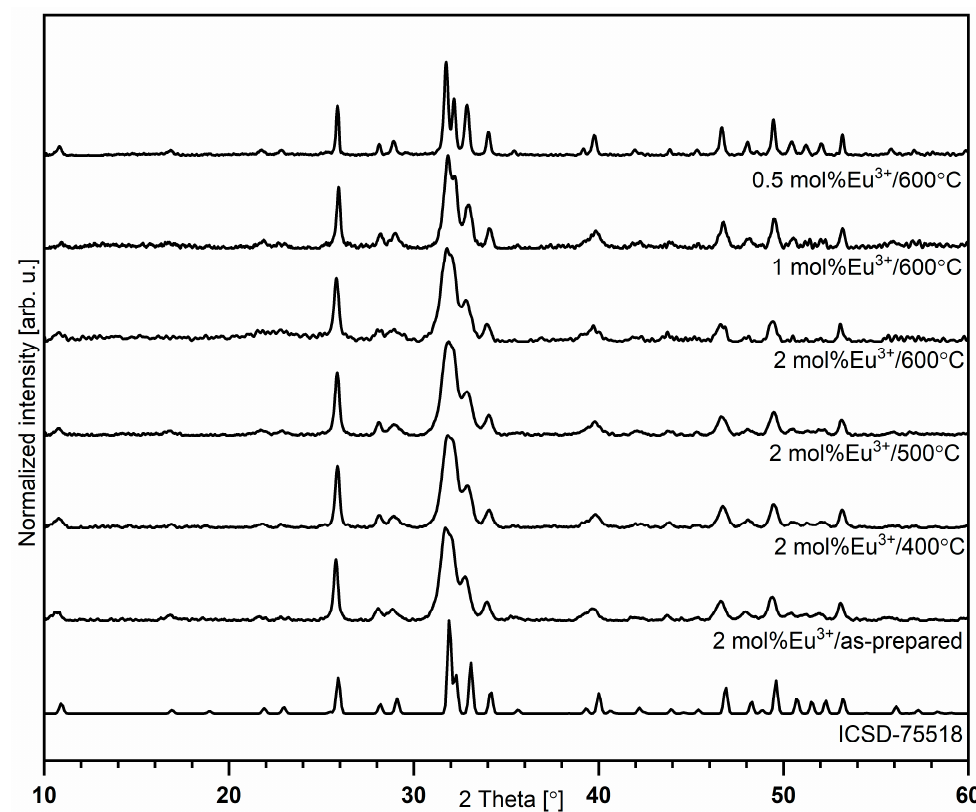
Figure 1. X-ray diffraction pattern of silicate-substituted hydroxyapatite co-doped with 2 mol% Sr 2+ and x mol% Eu 3+ ions.